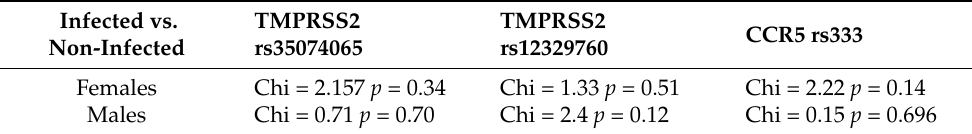
Figure 4. Genotype distribution of the rs35074065, rs12329760, and rs333 polymorphisms in the intellectual disability patients cohabiting in the Oasi M. Santissima IRCCS (Troina, Italy) sub-divided by severity of COVID-19 disease. rs35074065: Chi-square = 5.482, p = 0.483, df = 6; rs12329760: Chi-square = 3.077, p = 0.799, df = 6; and rs333: Chi-square = 3.792, p = 0.284, df = 3. No statistically significant correlation was obtained between disease severity and the three polymorphisms analyzed. Table 2. Statistical analysis between infected (COVID-19 positive) and non-infected (COVID-19 negatives) females and males.